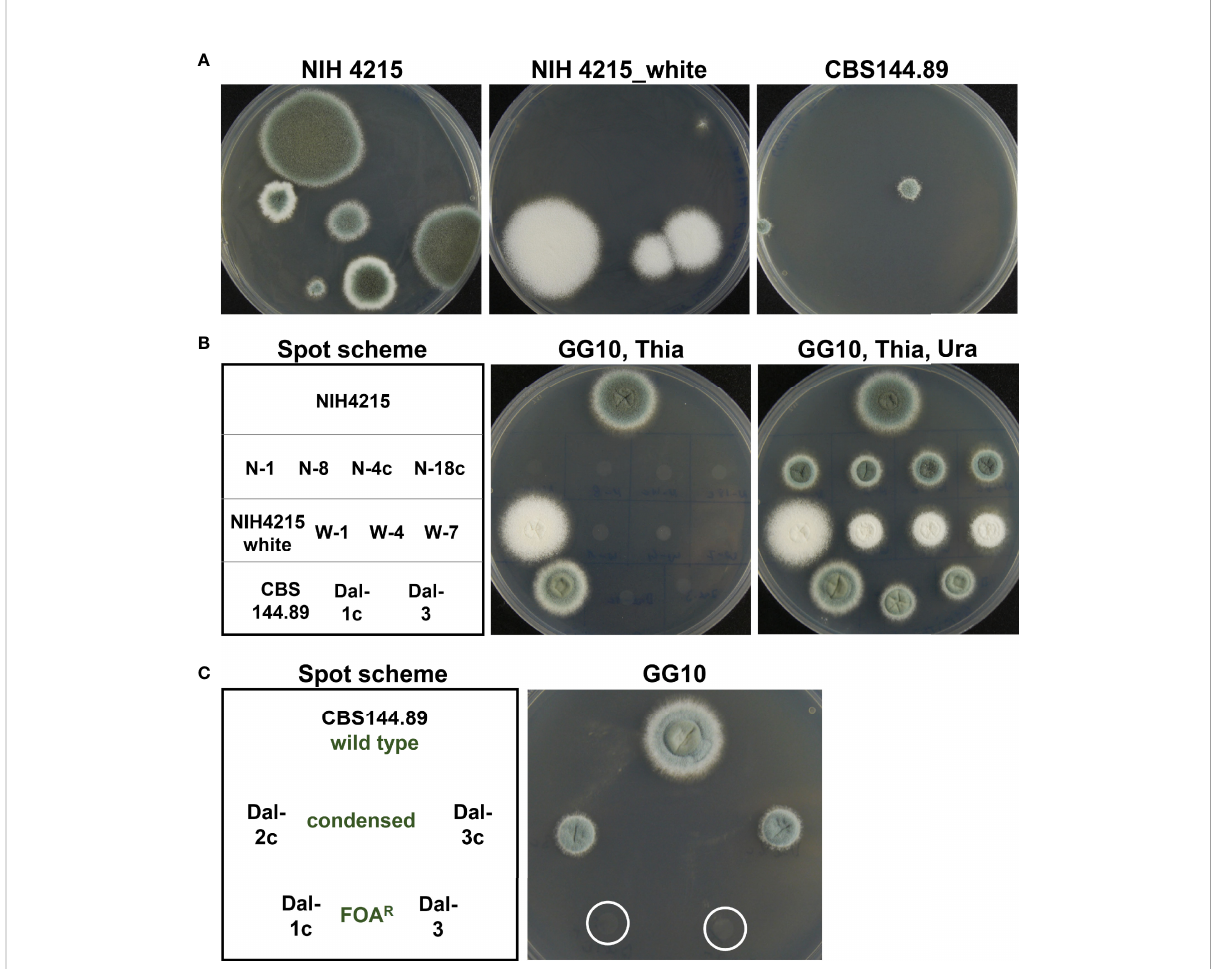
FIGURE 9 Screen for fl uoroorotic acid resistant mutants. (A) Five HEPES-buffered (20 mM, pH 7.0) plates containing GG10 medium supplemented with 12.5 µg/ml thiamine, 10 mM uracil and 4 mg/ml fl uoroorotic acid (FOA) were inoculated with 2 × 10 7 conidia of strain NIH4215, the white NIH4215 mutant, or strain CBS144.89 and incubated for 7 days at 37°C. Between 2 and 6 FOA resistant colonies per plate were obtained for NIH4215 and its white mutant and between 0 and 3 colonies per plate with a condensed phenotype for CBS144.89. Representative photographs of plates are shown. (B) Analysis of selected FOA-resistant strains for uracil auxotrophy. For CBS144.89 non-condensed growing FOA-resistant mutants from various screens (see main text) were selected. For genotypes of FOA-resistant strains from NIH4215 and CBS144.89 strains refer to Table 2. (C) Analysis of Uracil auxotrophy of colonies from CBS144.89 with condensed and non-condensed phenotype. The mutants with condensed phenotype do not require uracil, but maintain the condensed colony morphology on minimal media without